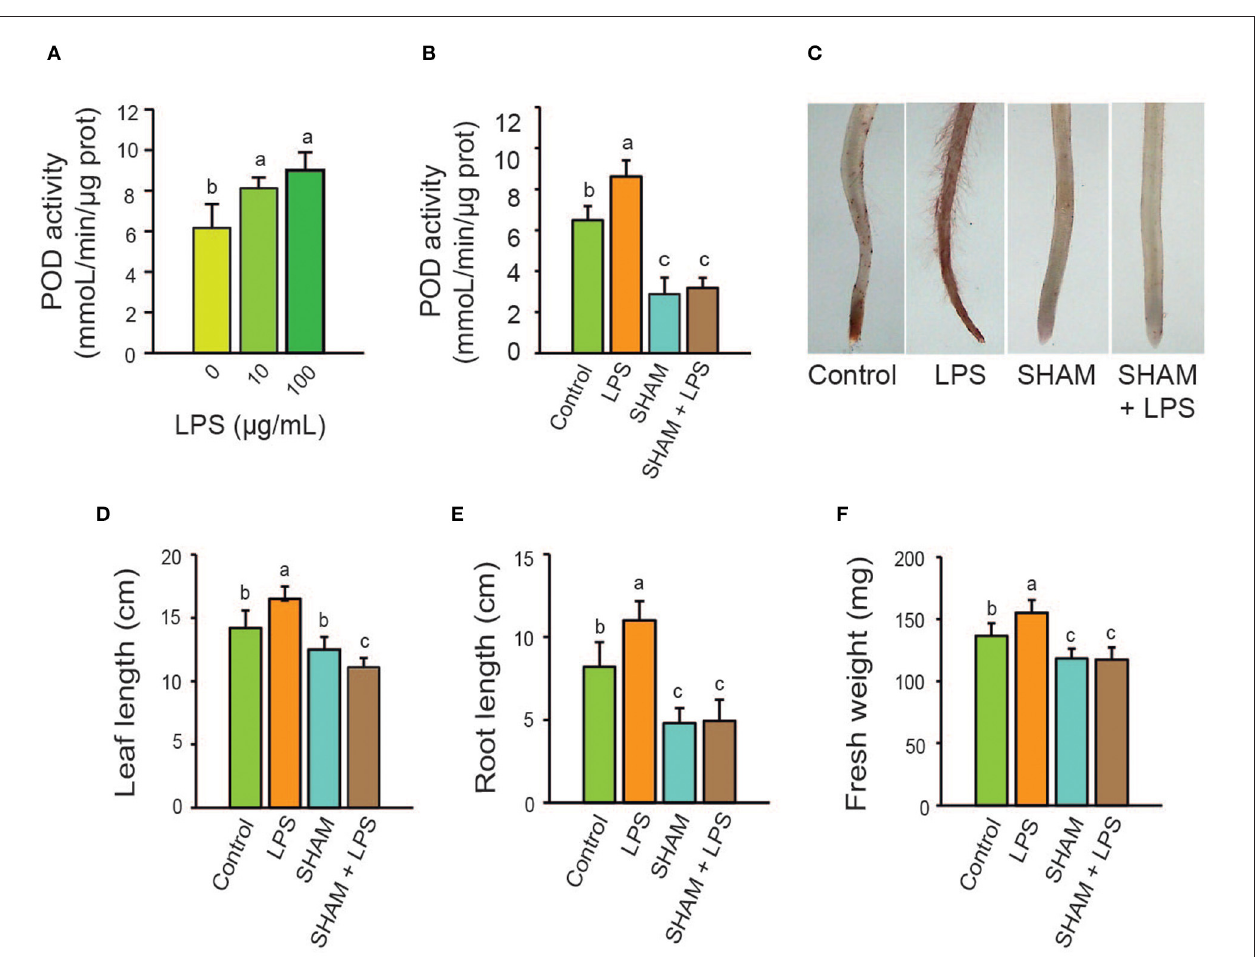
FIGURE 2 | Effect of A. brasilense LPS on POD enzyme activity. Seedlings were treated with LPS and the POD inhibitor SHAM alone or in combination with LPS. Plant growth parameters were analyzed 4 days after treatment. (A) Increasing LPS concentrations were used to assay POD activity in roots 4 days after treatment. (B) Effect of LPS and SHAM on POD activity. (C) Image of i n vivo detection of POD activity with DCPIP in roots. (D) Leaf length. (E) Root length. (F) Total fresh weight. LPS, Lipopolysaccharides; SHAM, salicylhydroxamic acid. Data are mean ± SE of three independent experiments ( n = 10). Letters above bars indicate significant differences according to a Duncan test ( p <